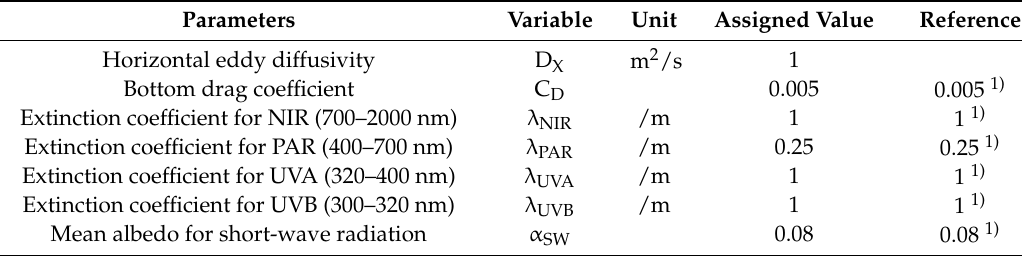
Table 2. Hydraulic parameters used in the estuary, lake, and coastal ocean model (ELCOM) for the Jinyang Reservoir.